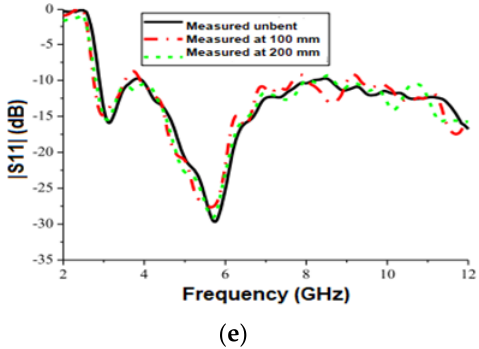
Figure 12. ( a ) The fabricated antenna prototype. ( b ) |S11| curve of the antenna. ( c ) |S21| curves of the antenna. ( d ) Measured radiation pattern. ( e ) Calculated |S11| for a flexible UWB MIMO antenna under bending. Reprinted ( a – e ) from Ref. [19].